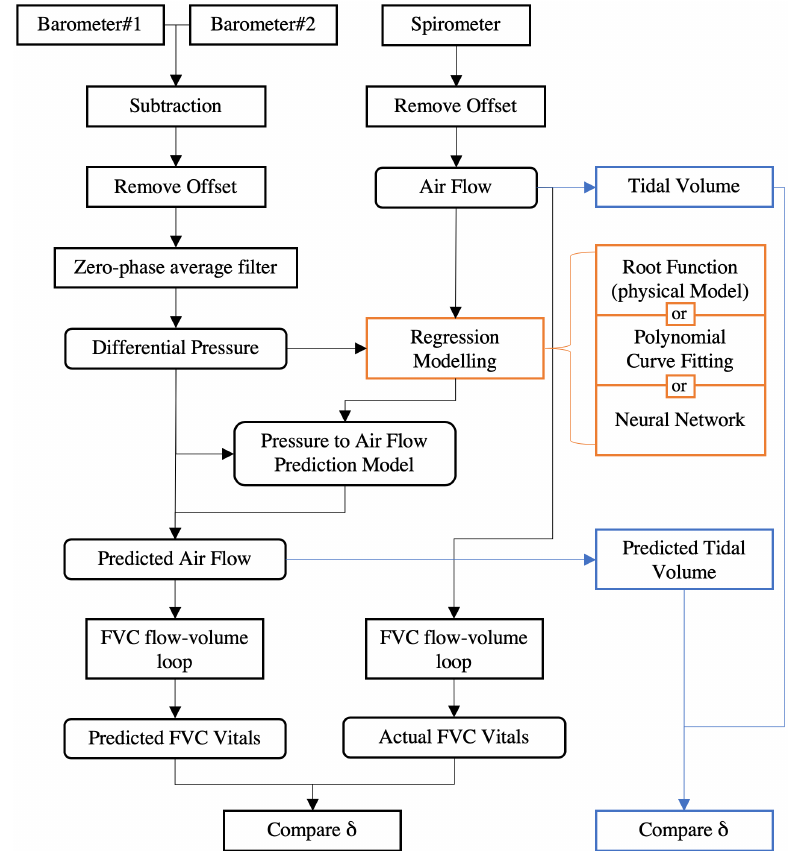
Figure 11. Flowchart of The major evaluation